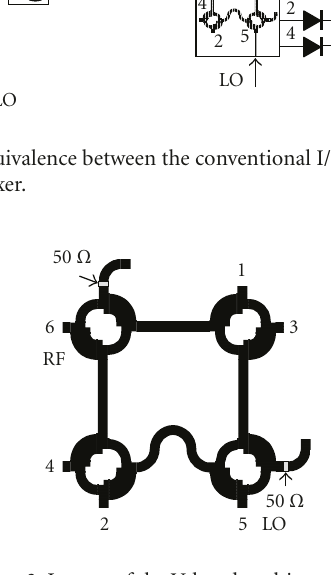
Figure 3: Layout of the V-band multiport